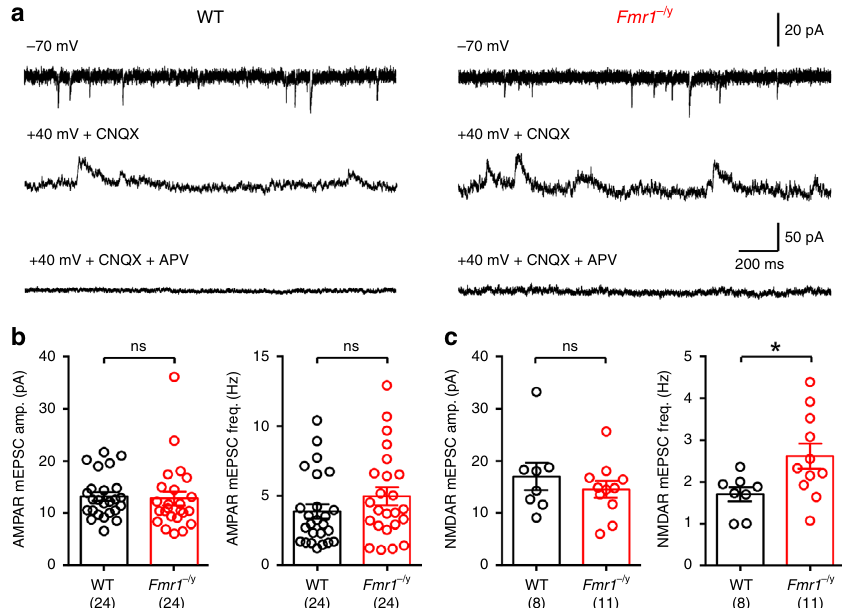
Fig. 5 mEPSCs in Fmr1 − /y L4 SCs show enrichment of NMDAR synapses. a mEPSCs recorded from L4 SCs for AMPAR at − 70 mV (top), NMDAR at + 40 mV with CNQX (10 µ M, middle), and following application of the NMDAR antagonist D-AP5 (50 µ M, bottom) in the same cell; from WT (left) and Fmr1 − /y (right) mice. b Quanti fi cation of AMPAR mEPSC amplitude (WT: 13.1 ± 0.8 pA; Fmr1 − /y ; 12.7 ± 1.3 pA) and frequency (WT: 3.9 ± 0.5 Hz; Fmr1 − /y ; 4.9 ± 0.6 Hz) in WT (black) and Fmr1 − /y (red) mice. Number of mice indicated in parenthesis. c NMDAR mEPSC amplitude (WT: 16.9 ± 2.6 pA; Fmr1 − /y ; 14.4 ± 1.6 pA) and frequency (WT: 1.7 ± 0.17 Hz; Fmr1 − /y ; 2.6 ± 0.3) measured in WT and Fmr1 − /y mice. Statistics shown: ns p > 0.05, * p < 0.05 from unpaired t -test. All data are shown as mean ± SEM and source data for all plots are provided as a Source Data fi